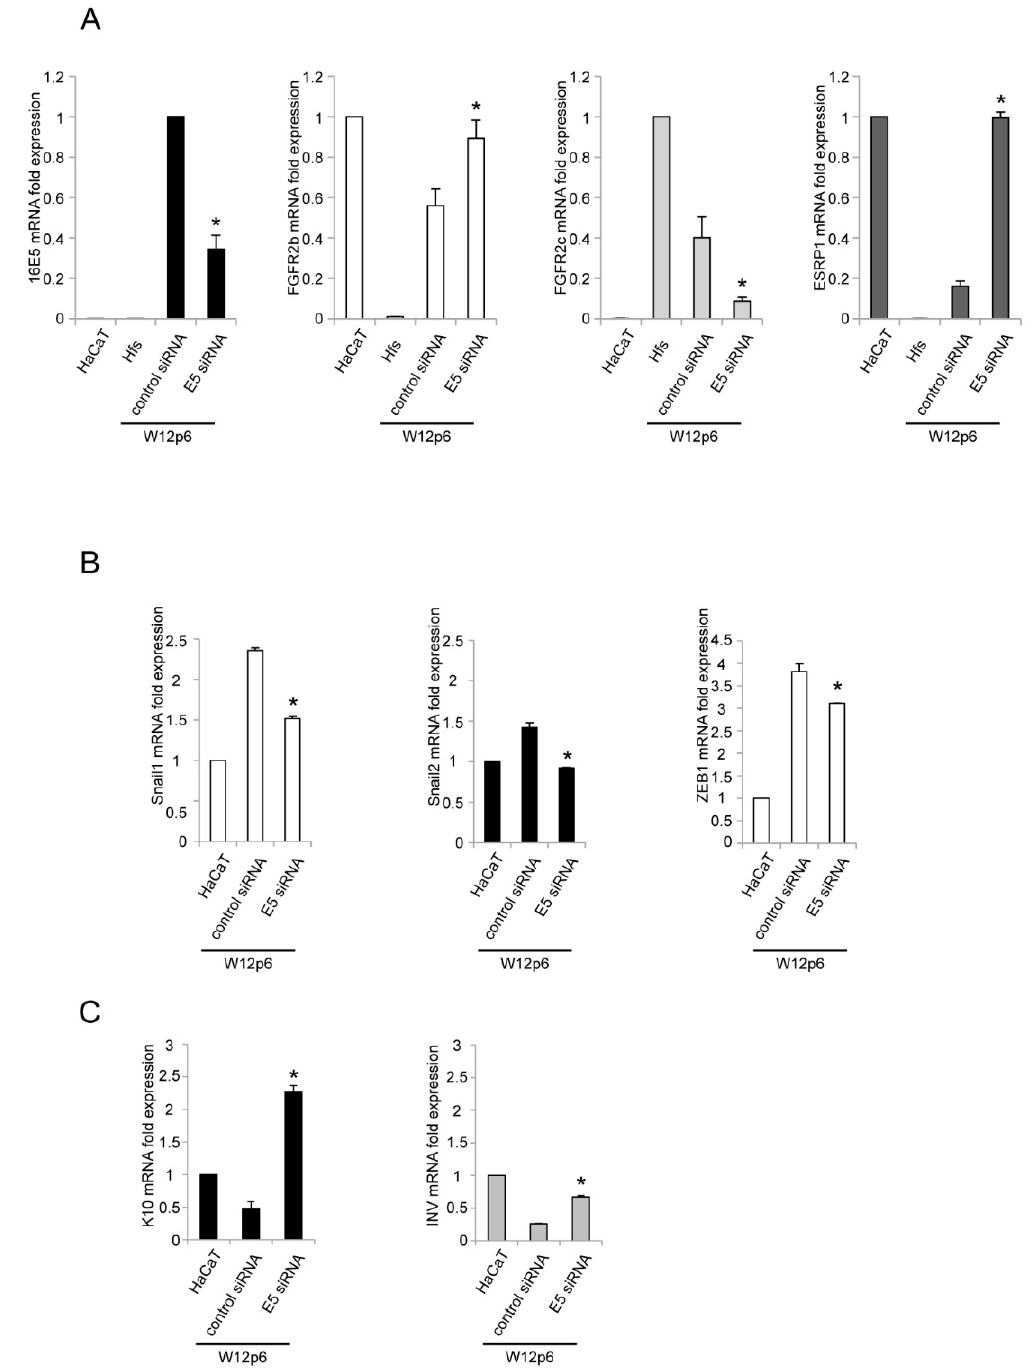
Figure 2. The oncoprotein 16E5 is responsible for ESRP1 downregulation, FGFR2 isoform switching, as well as for the induction of EMT-related transcription factors and the downregulation of keratinocyte differentiation markers. W12p6 cells were transiently transfected with 16E5 siRNA or with unrelated siRNA as a negative control (control siRNA). HaCaT cells and primary cultures of human dermal fibroblasts (Hfs) were used to confirm the tissue-specific expression of FGFR2b and ESRP1 in the epithelial cells, and that of FGFR2c in the mesenchymal cells. After transfection, the 16E5 mRNA levels, as well as those of FGFR2b, FGFR2c, ESRP1 ( A ), Snail1, Snail2 and Zeb1 ( B ), keratin 10 (K10) and involucrin (INV) ( C ) were quantified by real-time PCR. Results are expressed as mean values ± SD. Student’s t -test: * p < 0.05 vs. the corresponding W12p6 control siRNA cells.